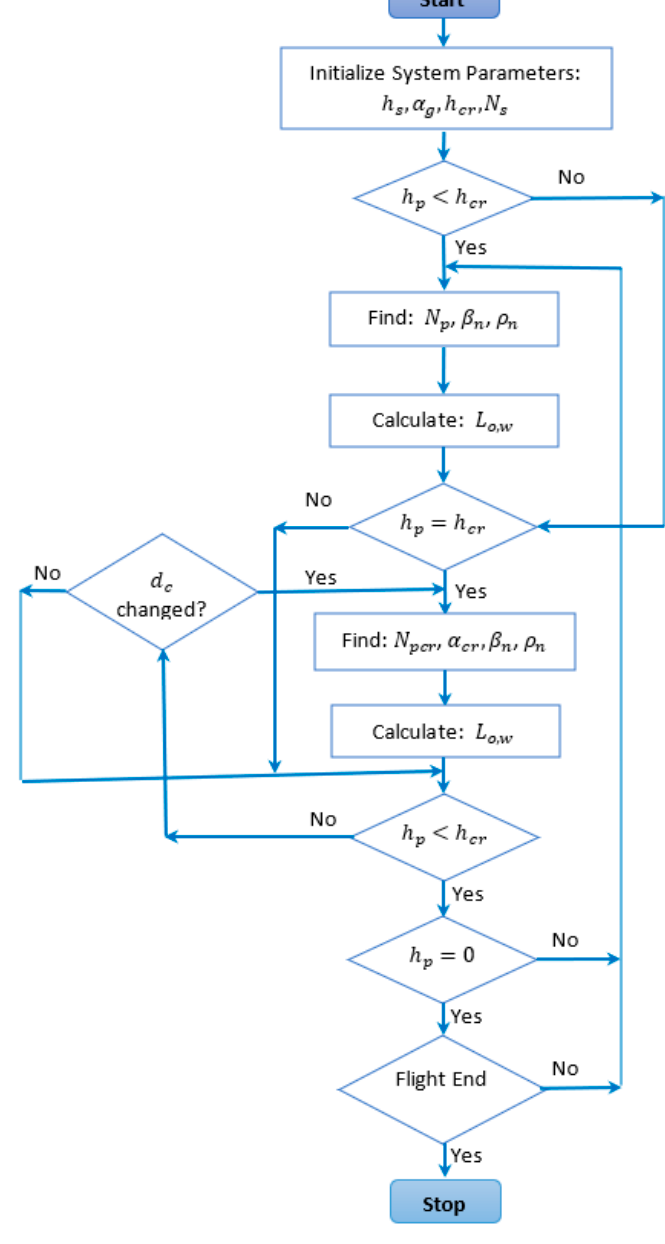
Figure 10. Atmospheric attenuation calculation flowchart during flight.